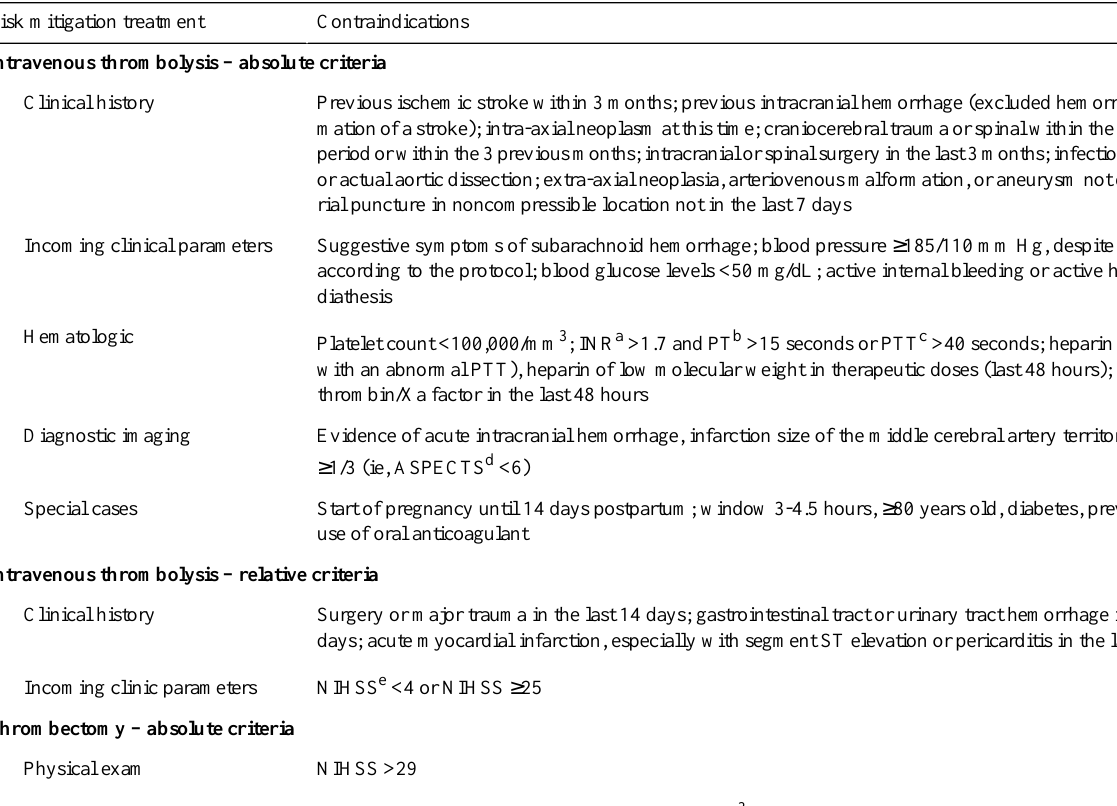
Table 2. Risk mitigation matrices for reperfusion therapies. ContraindicationsRisk mitigation